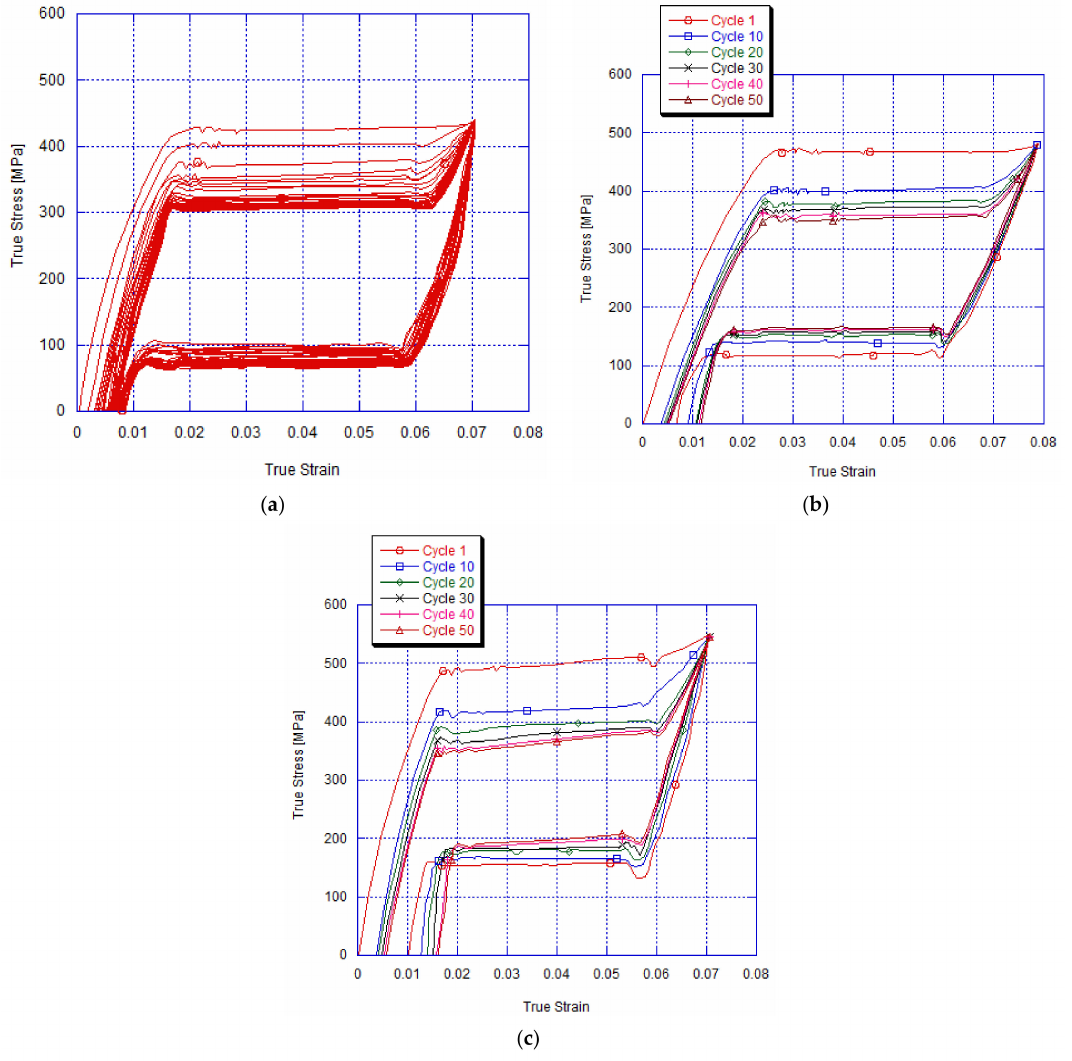
Figure 5. Typical strain cycling curve after 50 cycles for deformed specimen until 7.1%, at imposed strain rate of ( a ) 10 − 5 s − 1 , ( b ) 10 − 4 s − 1 and ( c ) 10 − 3 s − 1 , showing reduction in phase-transformation yield stress and increase in residual